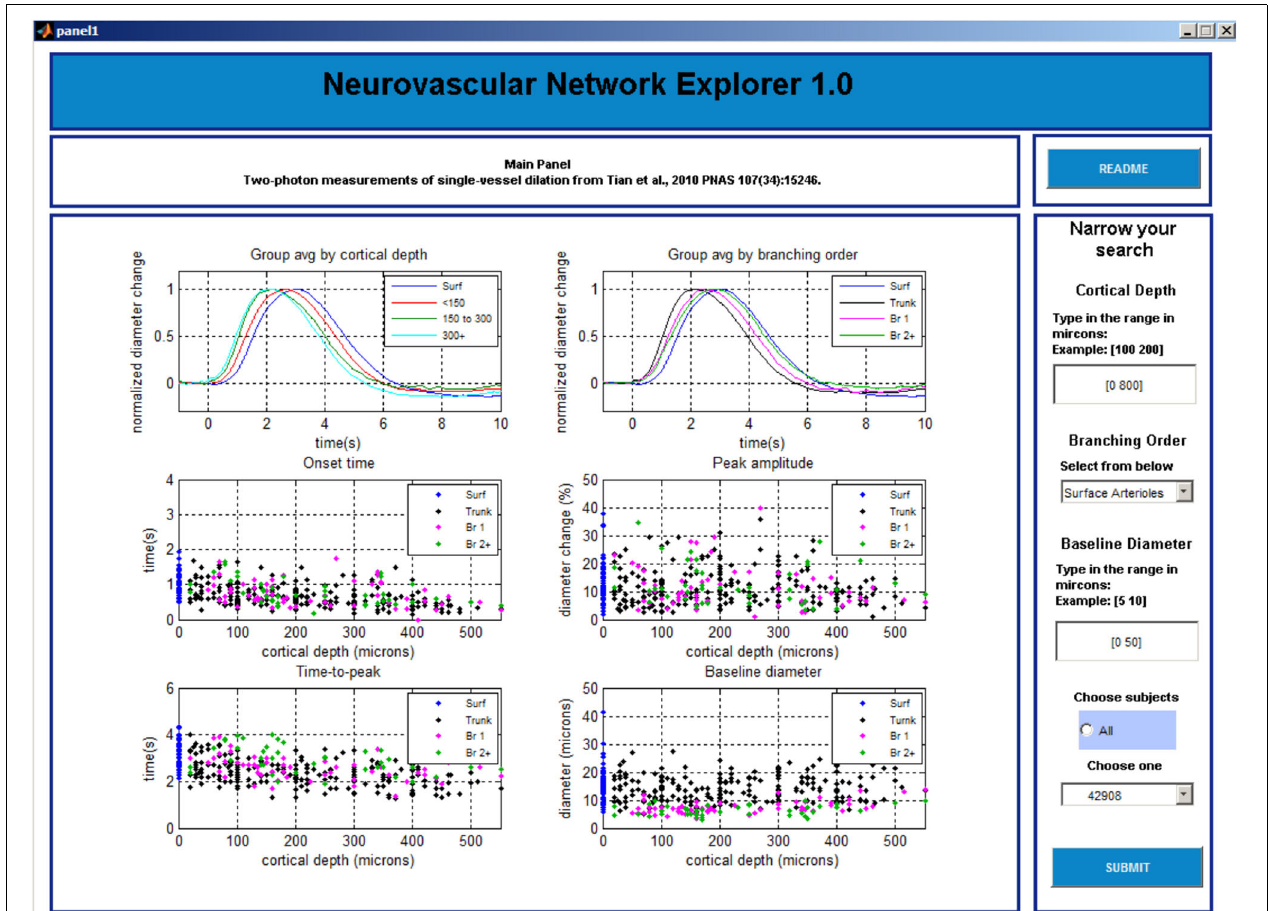
FIGURE 3 | GUI, panel